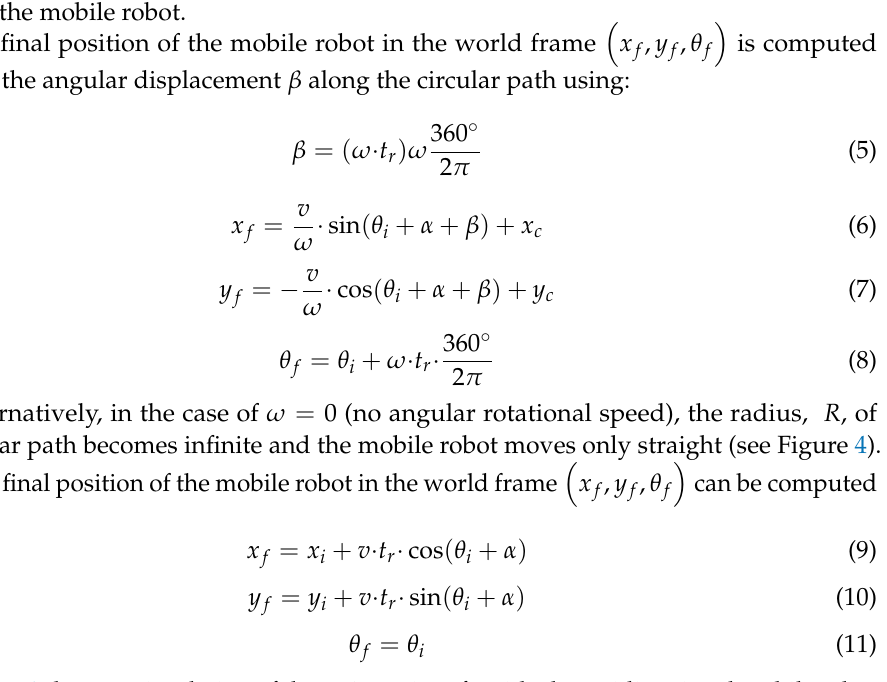
Figure 5. Representation of the trajectory of the mobile robot: ( a ) case with translation and rotation in the counterclockwise direction (𝜔 > 0) and ( b ) case with translation and rotation in the clockwise direction (𝜔 < 0) .